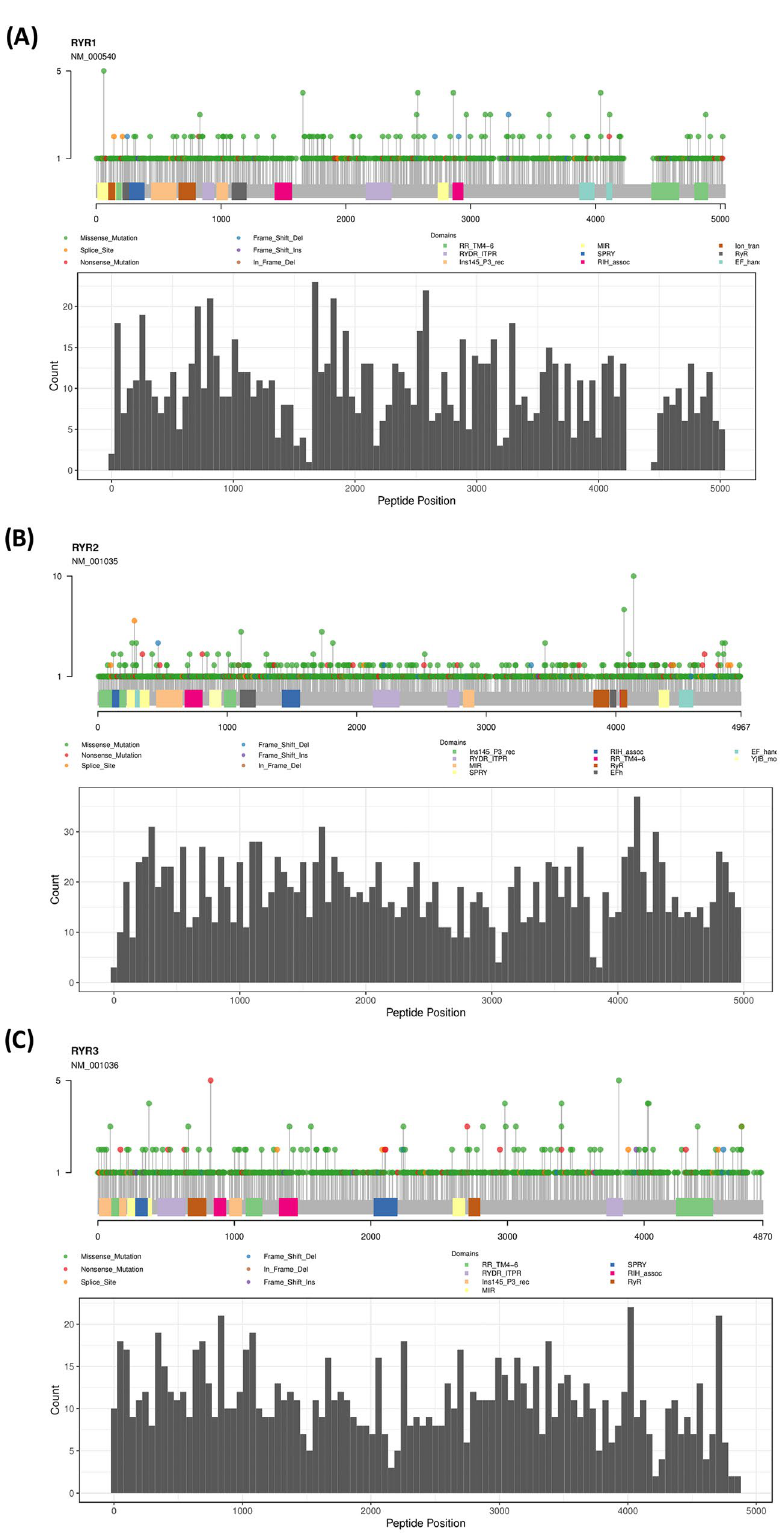
Figure 1. The mutational landscape for RYR1,RYR2 and RYR3 in cancer patients. All mutations identified in TCGA database are plotted on the schemes of RYR1 ( A ), RYR2 ( B ) and RYR3 ( C ). Mutations are presented by dots, and colors represent mutation types. The Y-axis represents the number of mutations for each site. Key RYR domains are labeled as indicated. The histograms in ( A – C ) show the number of mutations of RYR1,RYR2 and RYR3 for every 150 bases (50 amino acids), representing the frequency of mutations at 150-base